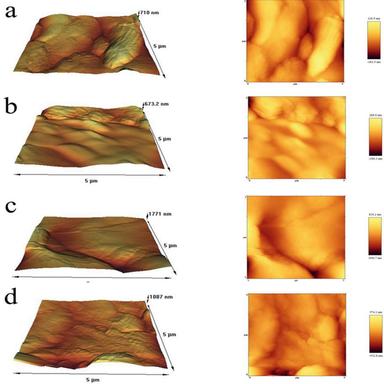
AFM images of sintered membranes: a) M-Z, b) M-Z-PS10, c) M-Z-PS20, d) M-Z-PS30.